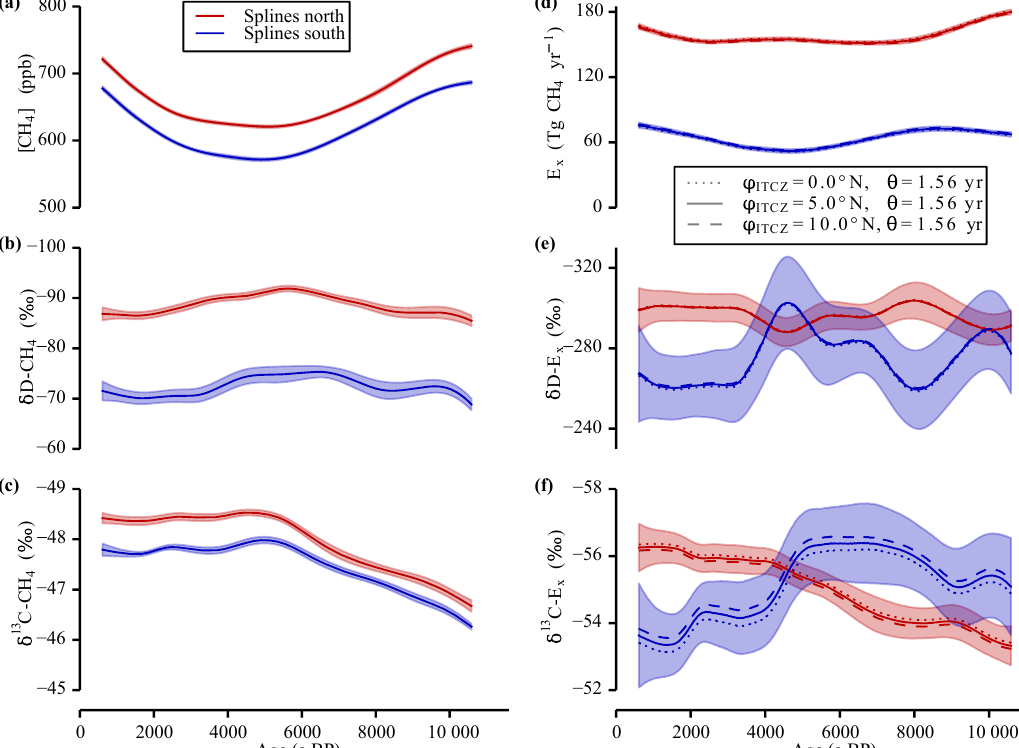
Figure 6. Sensitivity study “ITCZ position”. In panels (a–c) the data splines with the 1 σ uncertainty error bands of the measured tropospheric values are shown. In panels (d–f) the calculated strengths and the isotopic signature of the emissions are shown for the three different ϕ ITCZ set-ups and the best-guess value for θ to investigate the sensitivity of the inversion to a shift of the ITCZ. Note the inverted y axes in panels (b) , (c) , (e) , and (f)